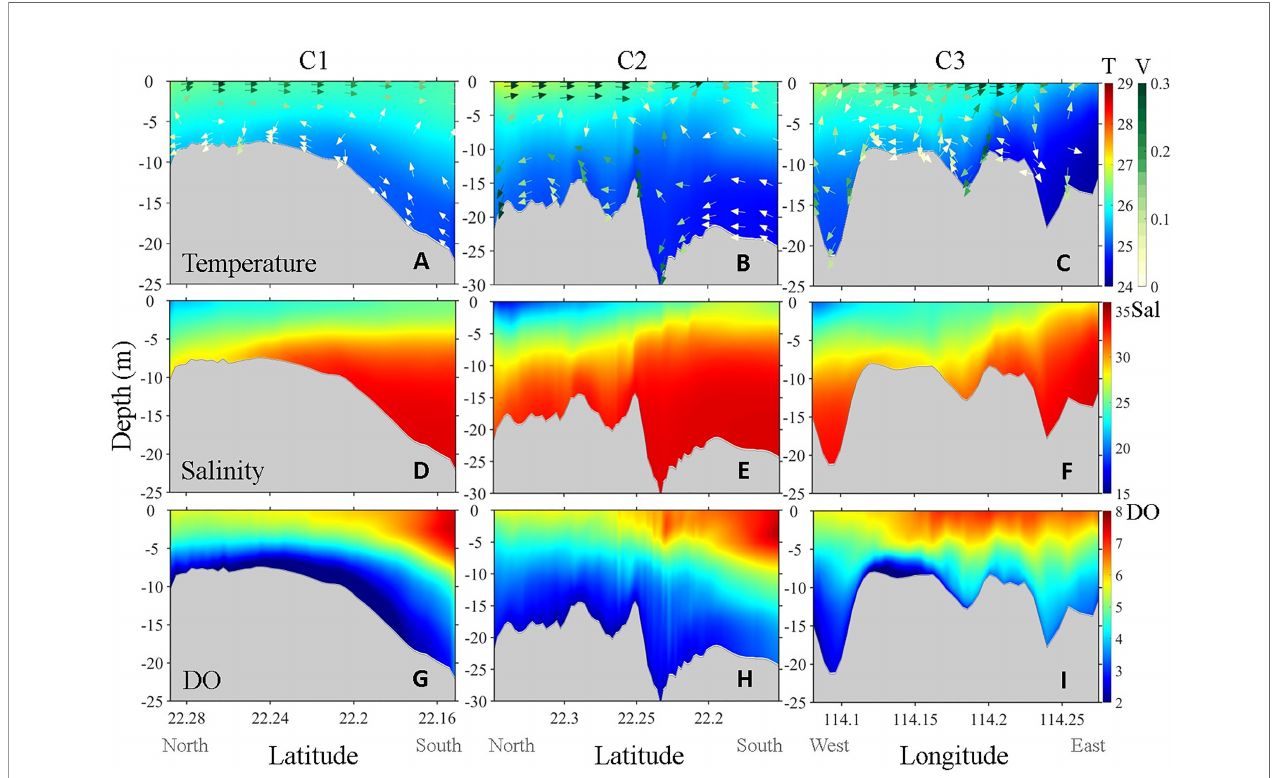
FIGURE 4 | Simulated vertical distribution of (A – C) temperature (°C, upper row), (D – F) salinity (PSU, mid row) and (G – I) DO (mg L − 1 , lower row) along Channel C1 (left column), C2 (mid column), and C3 (right column) on day 40. The colored arrows superimposed on the color contour are the along-channel velocity fi eld (m s − 1 ). The color bar located at the inner right side denotes temperature (upper row), salinity (mid row) and DO (lower row), and the color bar located at the outer right side denotes the current